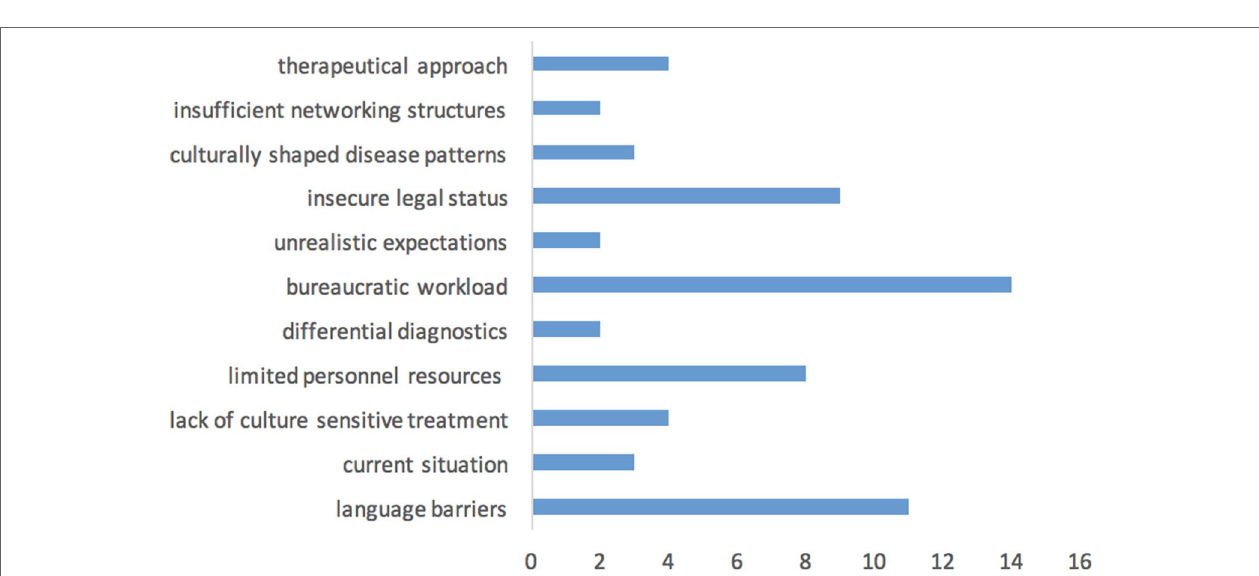
FIGURE 3 | Numbers of refugee patients in seven psychiatric clinics in Lower Saxony in the first quarter of 2018 ( N = 7 psychiatric clinics).